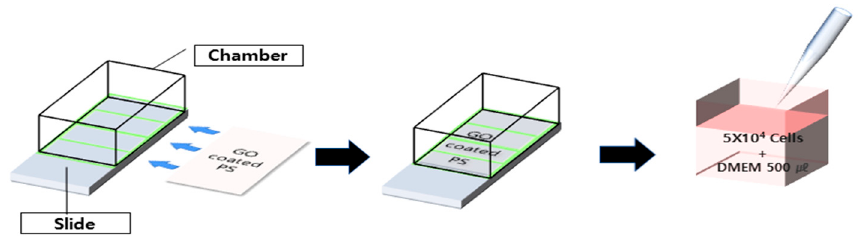
Figure 2. Preparation of a cell culture slide coated with a GO-coated polystyrene